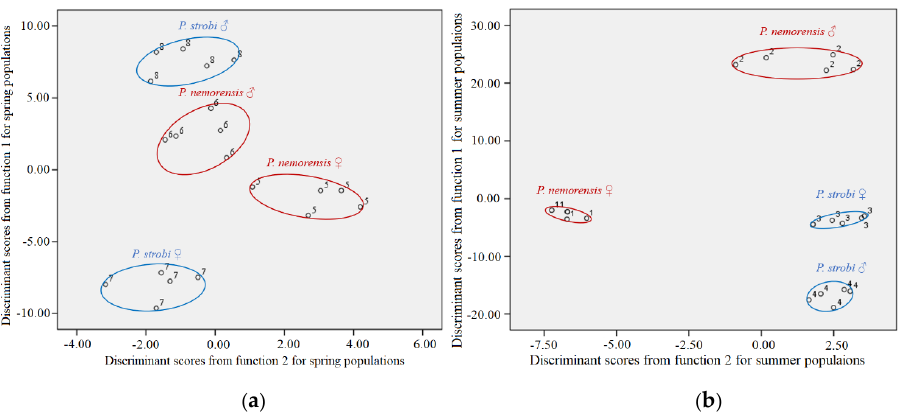
Figure 2. Scatter plots from discriminant analyses (DA) for the cuticular hydrocarbon (CHC) profiles of both sexes of Pissodes strobi and Pissodes nemorensis in the spring population ( a ), summer population ( b ). 1, 2, 3 and 4 represent female P. nemorensis , male P. nemorensis , female P. strobi , and male P. strobi in summer, respectively; 5, 6, 7, and 8 represent female P. nemorensis , male P. nemorensis , female P. strobi and male P. strobi in spring, respectively.